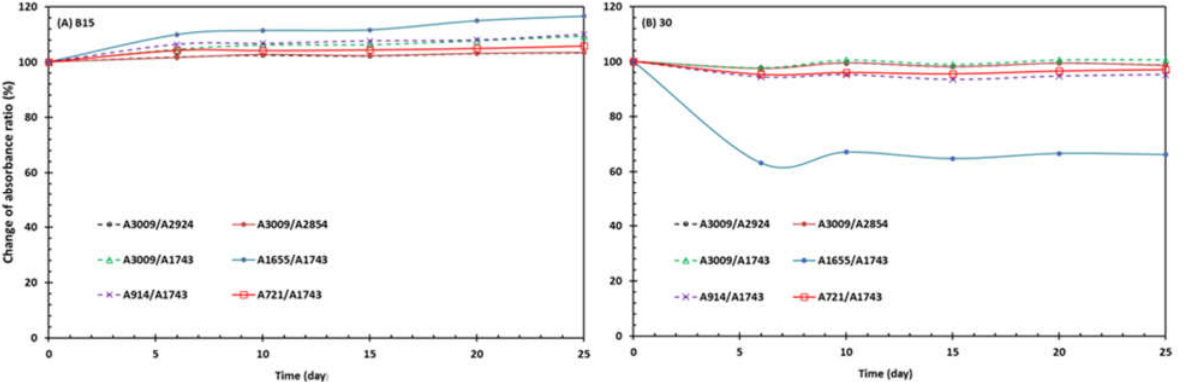
Figure 3. Relative changes (%) of selected ATR–FTIR absorbance ratios over the accelerated oxidation storage for 60 days at 60 ◦ C. ( A ) B15 and ( B ) B30 are butter products made from the cottonseed roasted at 150 ◦ C for 15 and 30 min, respectively.